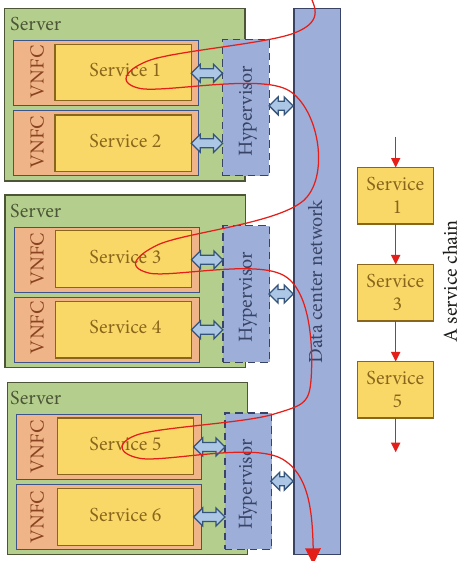
Figure 1: A typical infrastructure of NFV and the service